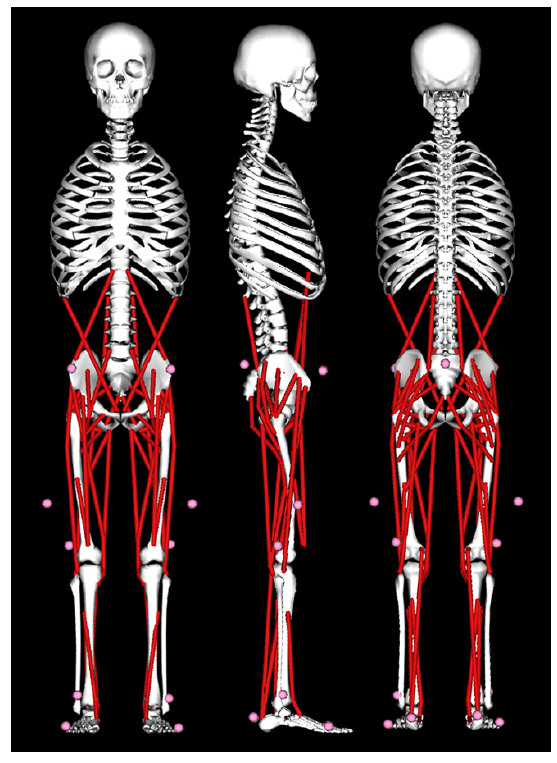
Figure 1. Musculoskeletal lower extremity model in OpenSim and marker placement used to identify the dynamic variables of the muscle